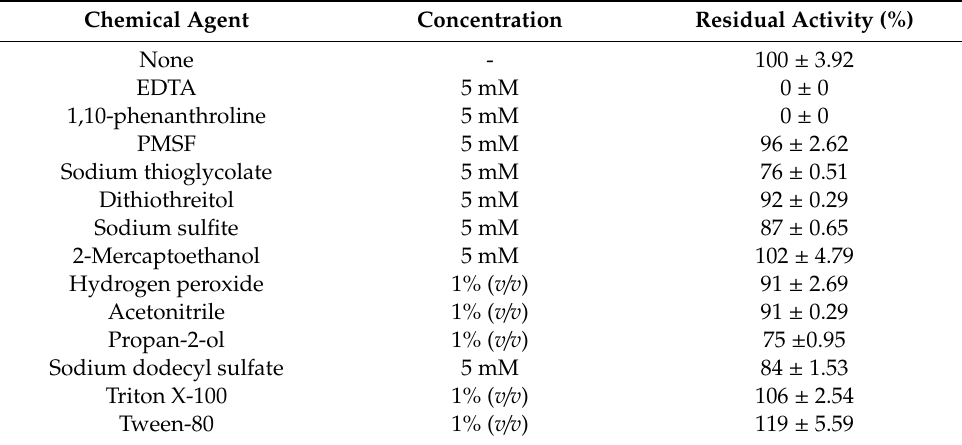
Table 3. E ff ect of chemical agents on KerBNK1